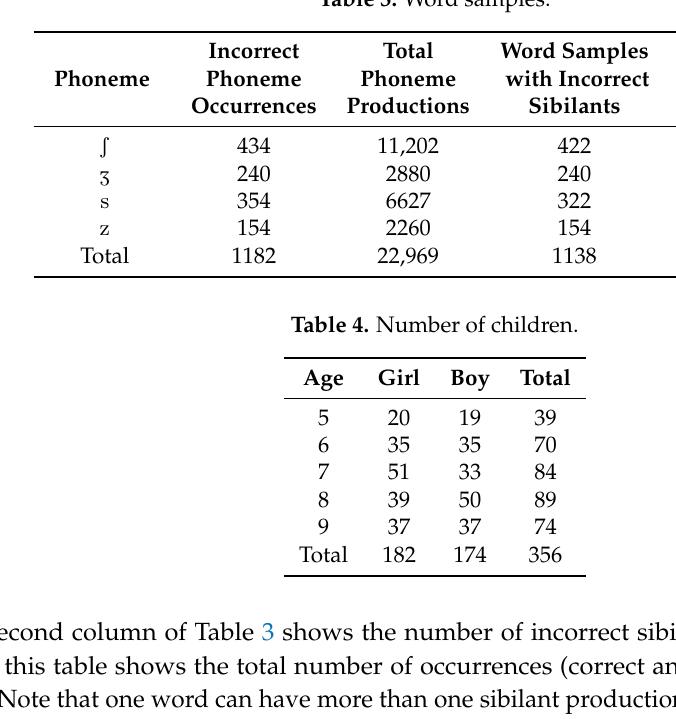
Figure 3. Stimulus used to suggest the word mochila . Table 3. Word samples.